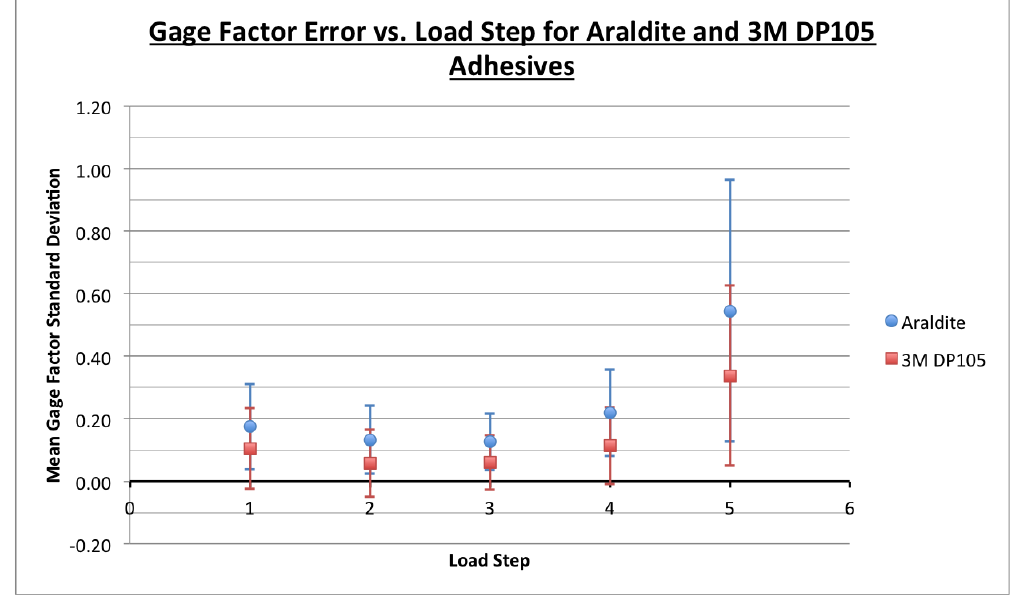
Figure 17. Apparent gage factor uncertainties for various load